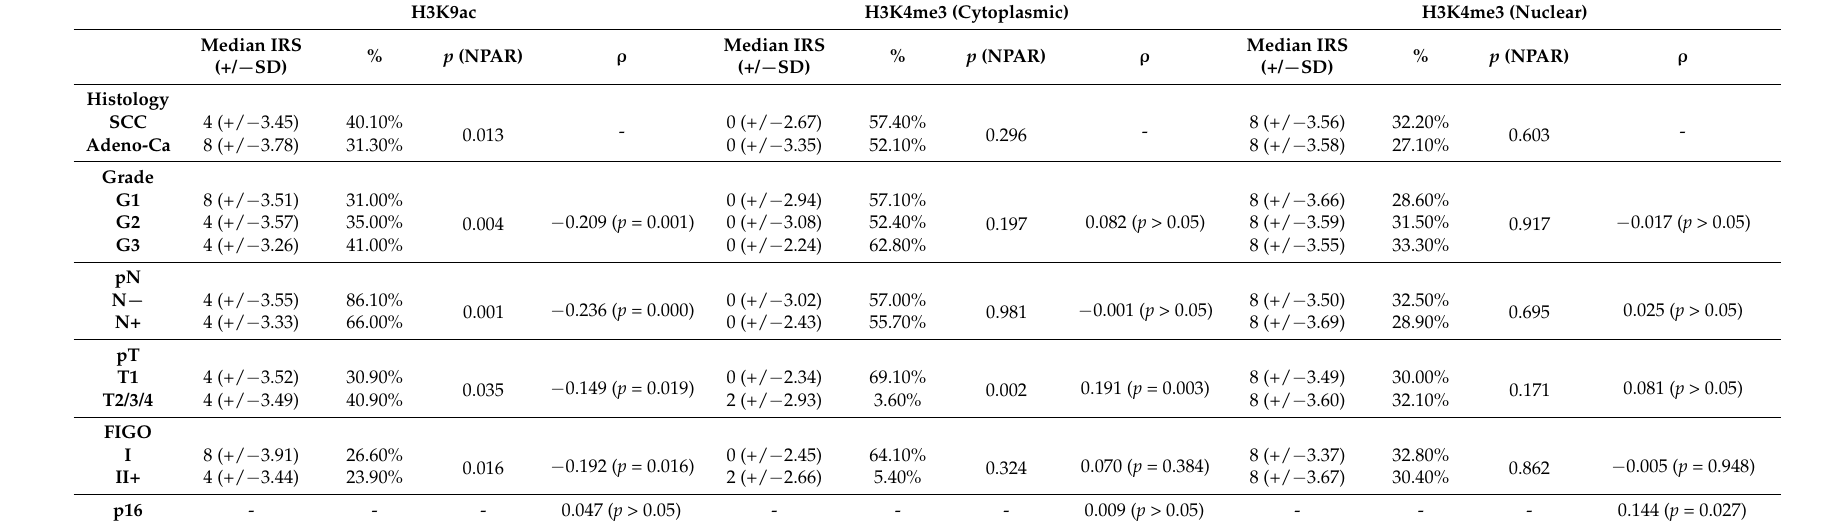
Table 2. Staining results and correlation